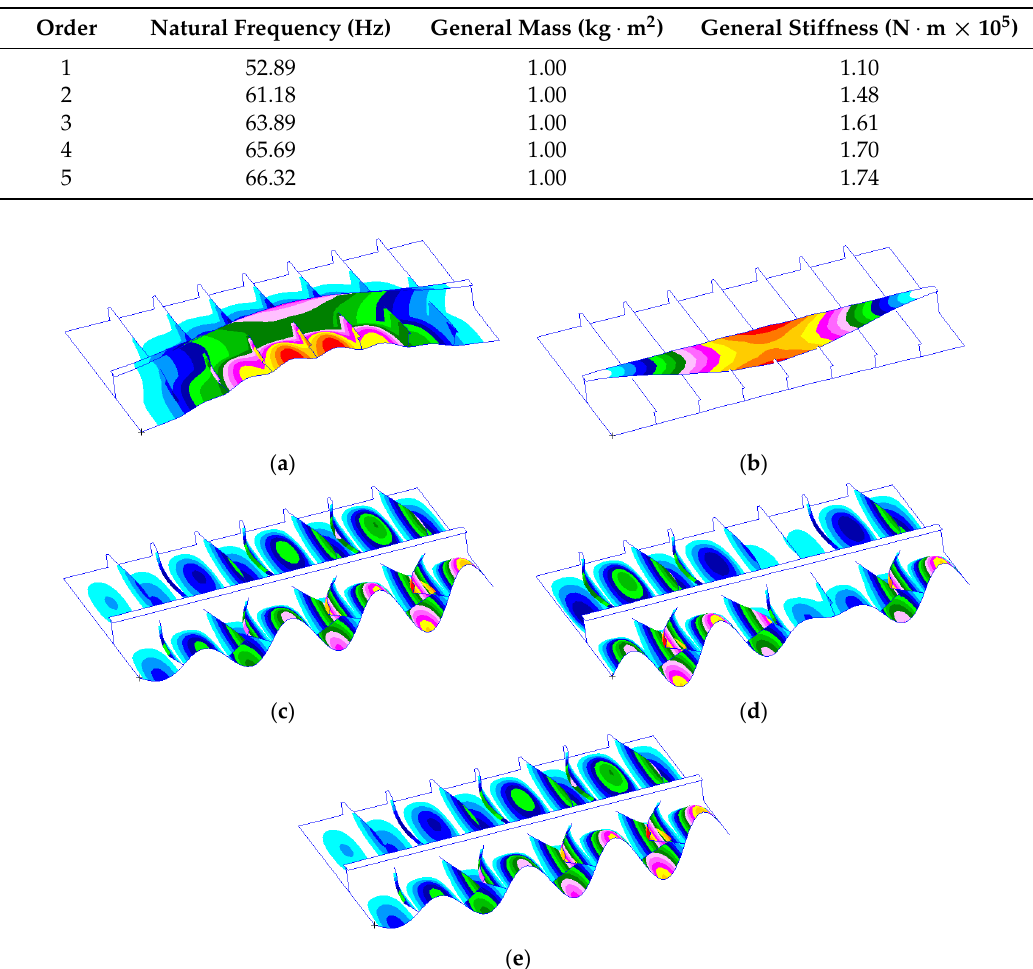
Figure A1. Displacement modes of the stiffened panel. ( a ) The first order; ( b ) The second order; ( c ) The third order; ( d ) The fourth order; ( e ) The fifth order.